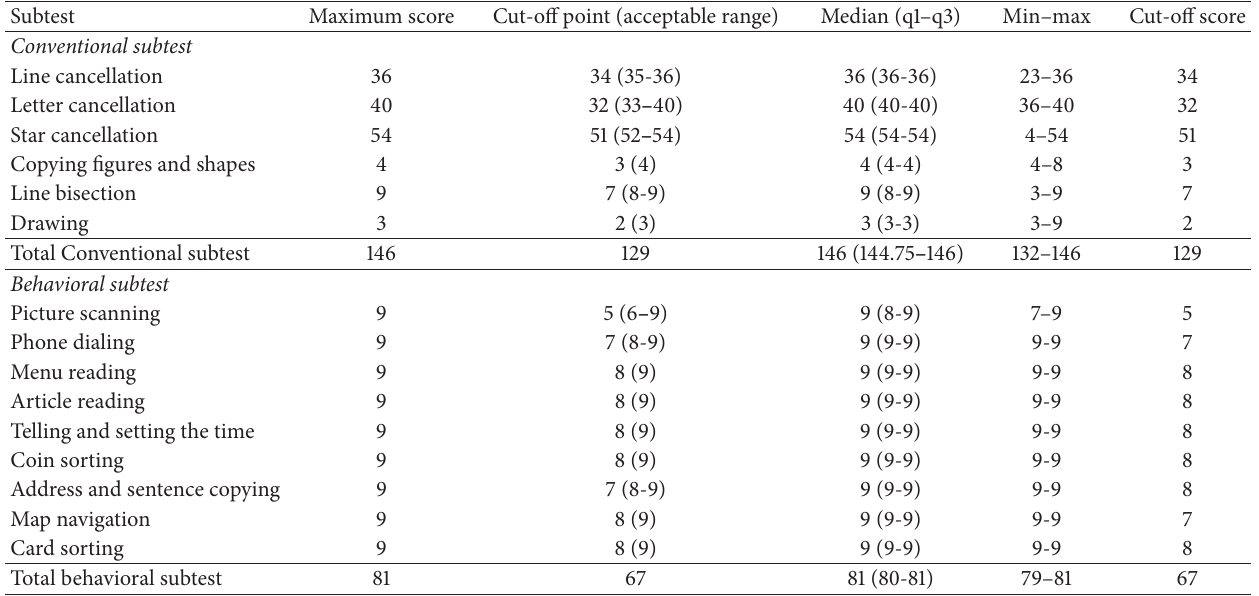
Table 3: Results obtained by healthy control participants in conventional and behavioral tests ( 𝑛 = 18 ).